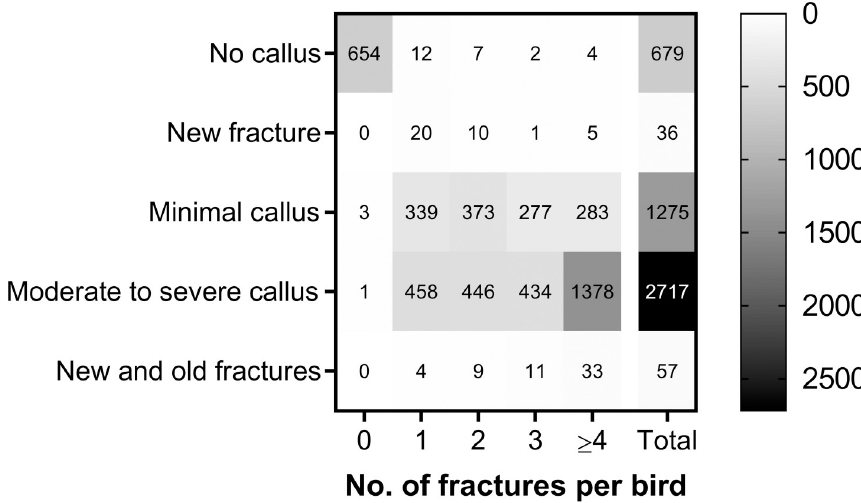
Fig 3. Heat map of the degree of callus formation in relation to the number of fractures detected in each hen (n = 4766). Values in the heat map cells represent the hen count.